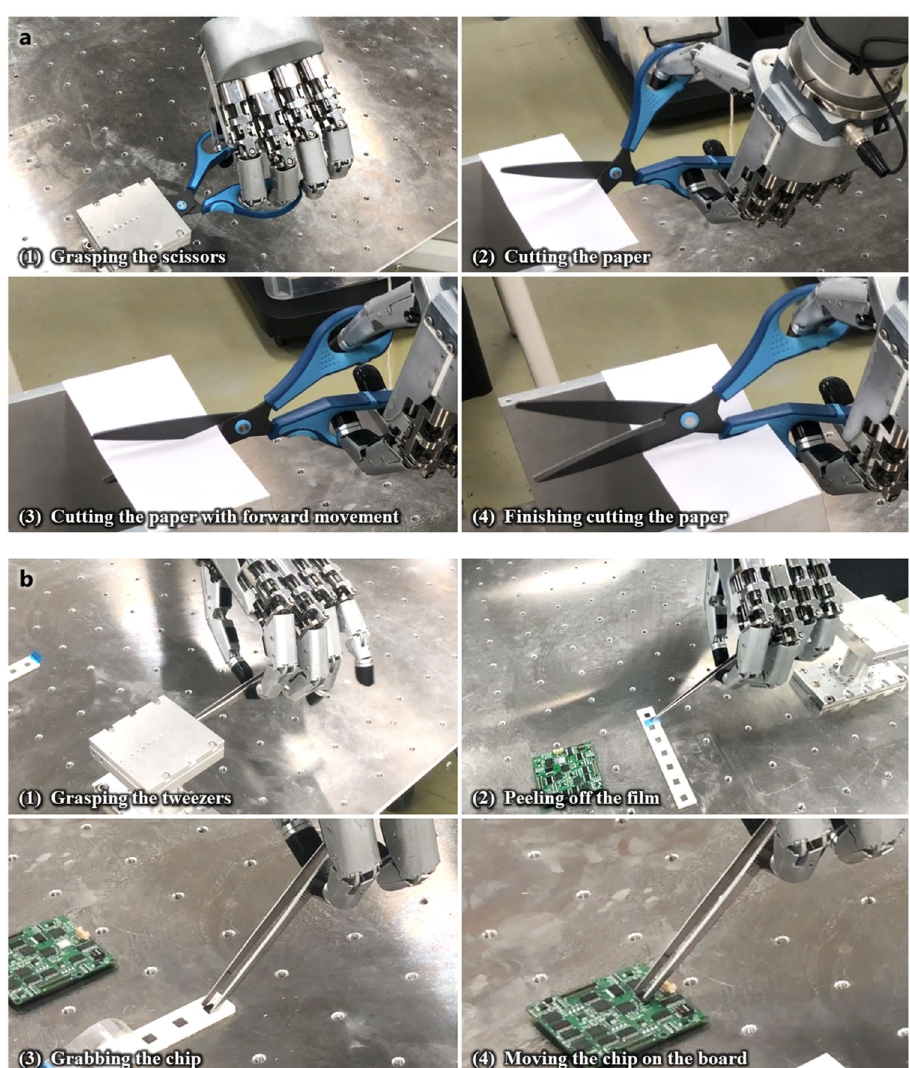
Fig. 8 Tool manipulation tests with the hand fi xed to the robotic arm. a Experiment where the hand cuts paper by holding and manipulating scissors. b Experiment where the robot grabs tweezers and manipulates the tips of the tweezers to grab and move a small